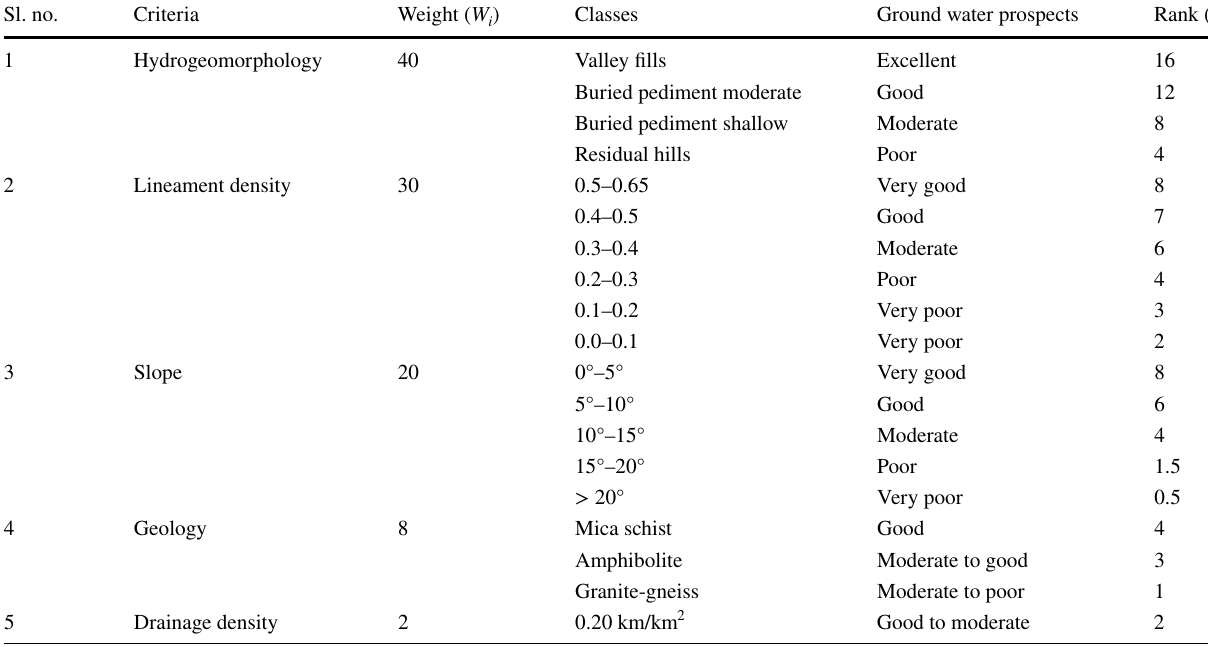
Table 1 Weightage of different parameters for groundwater prospect zonation Sl.